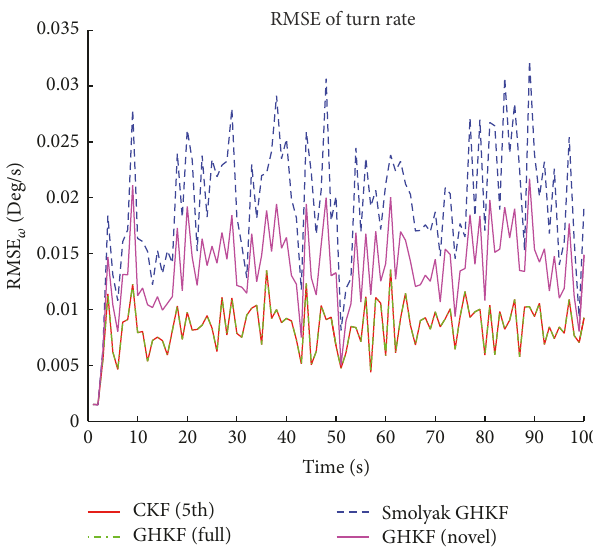
Figure 7: RMSEs of turn rate of different